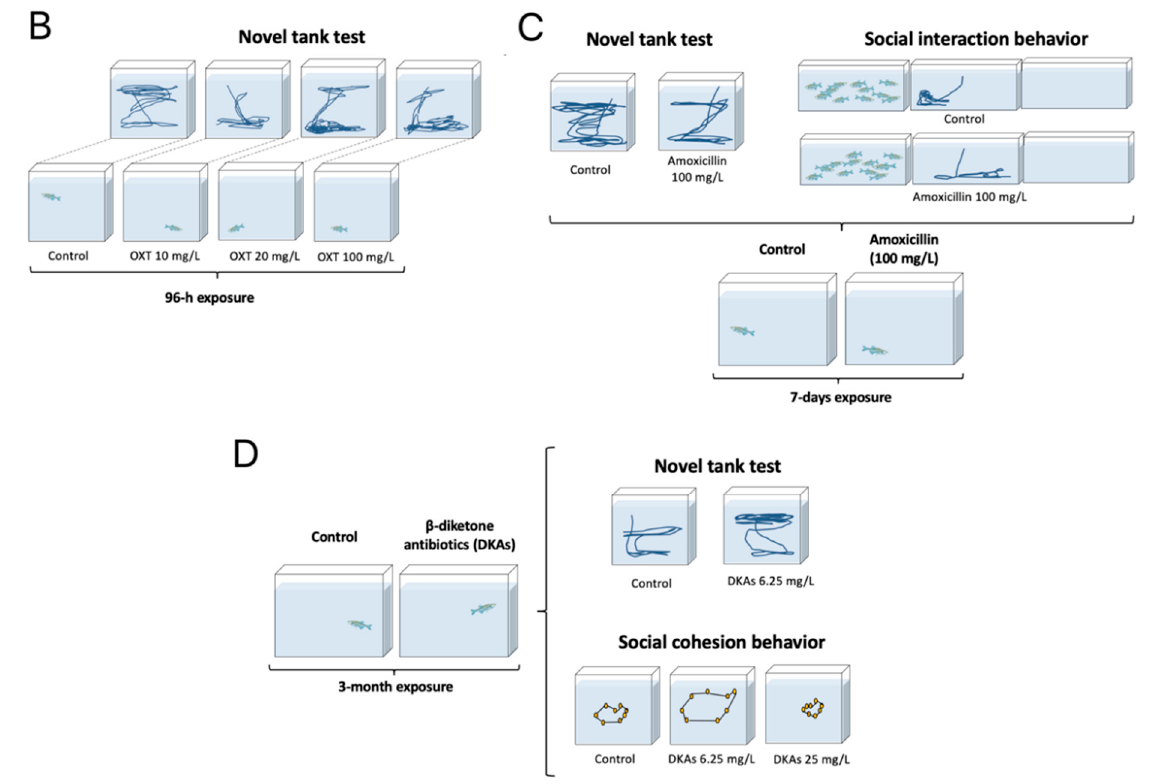
Figure 1. Selected examples of antimicrobial drugs’ effects on zebrafish behavior. ( A ) Exposure to chlortetracycline, ciprofloxacin, or ceftazidime for 96 h increases ( ↑ ) exploratory activity (more distance travelled), aggression (more bites in the mirror test), and cognitive deficits (more errors in the Y-maze) [42]. ( B ) Exposure to oxytetracycline (10–100 mg/L) for 96 h evokes anxiety-like behavior in the novel tank test [61]. ( C ) Exposure to amoxicillin (100 mg/L) for 7 days reduces distance travelled and social interaction [49]. ( D ) Chronic exposure to β -diketones (at 6.25 mg/L) increases time spent at the top of the test tank (an anxiolytic-like behavior) and alters (increases at 6.25, and decreases at 25 mg/L) shoaling behavior [41].